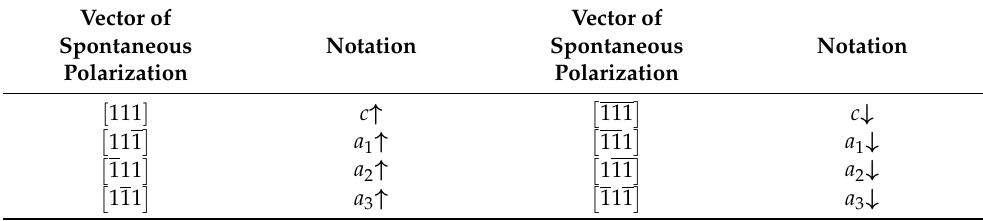
Table 1. Notations for the spontaneous polarization vector for the [111] oriented rhombohedral cell. Vector of Spontaneous Polarization